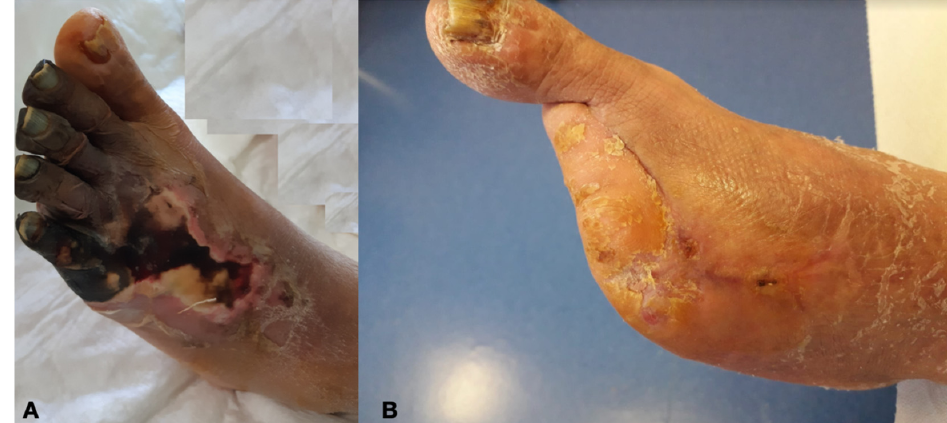
Figure 6. Diabetic Foot before ( A ) and after ( B ) revascularization with transmetatarsal amputation.